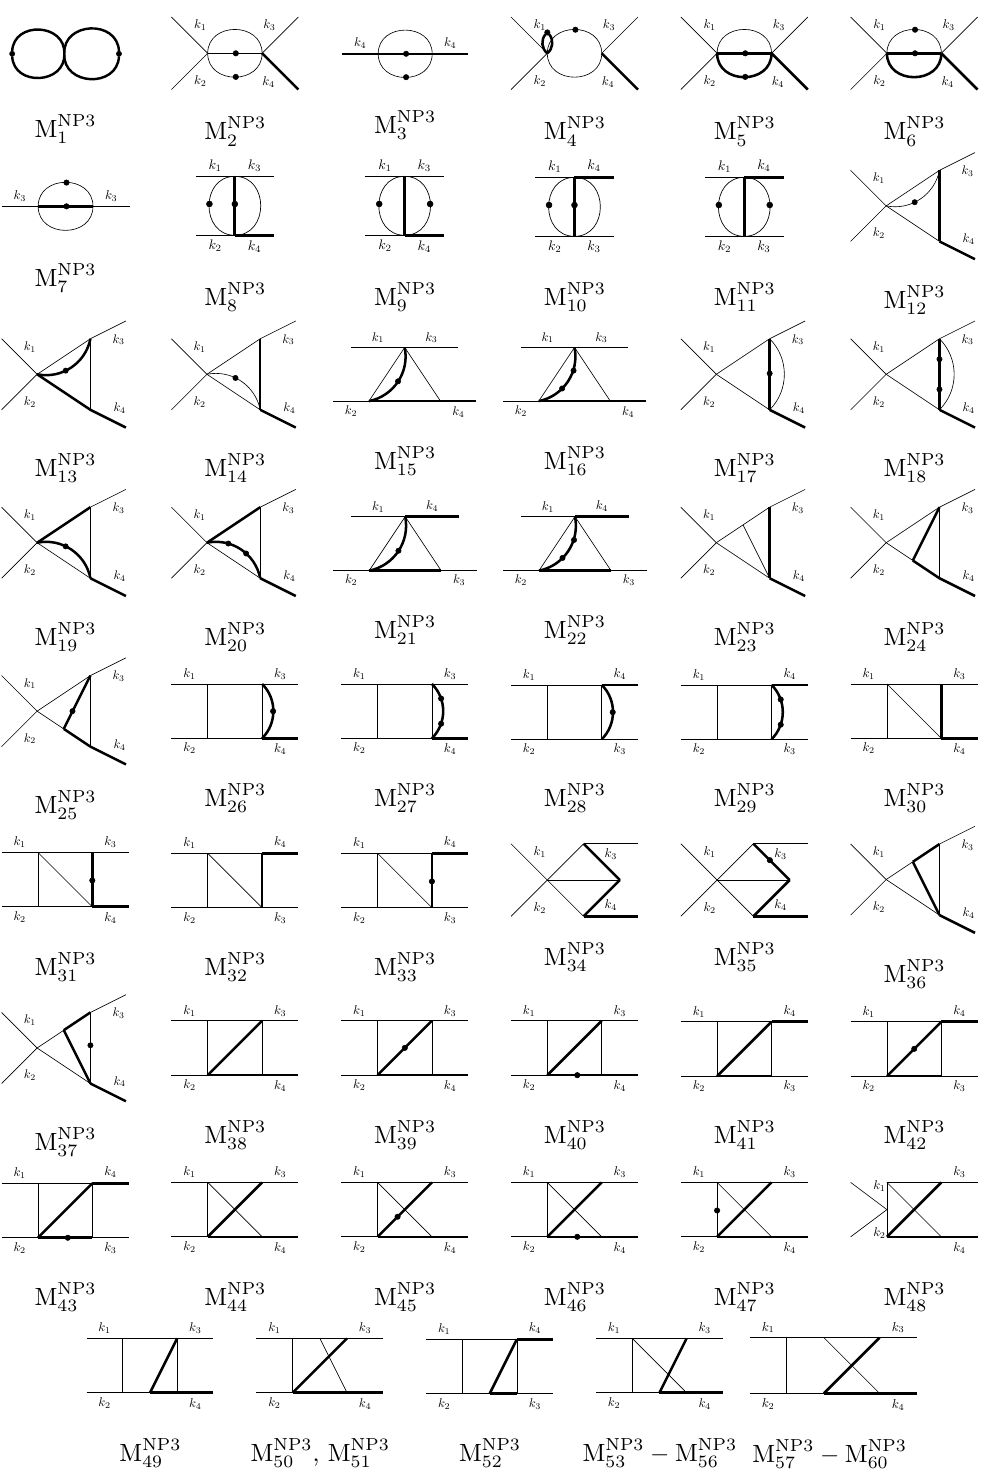
Figure 7. Master integrals in the NP3 topology. The thick lines stand for massive top quarks while the others represent massless particles. One black dot indicates one additional power of the corresponding propagator. The numerators can be found in the